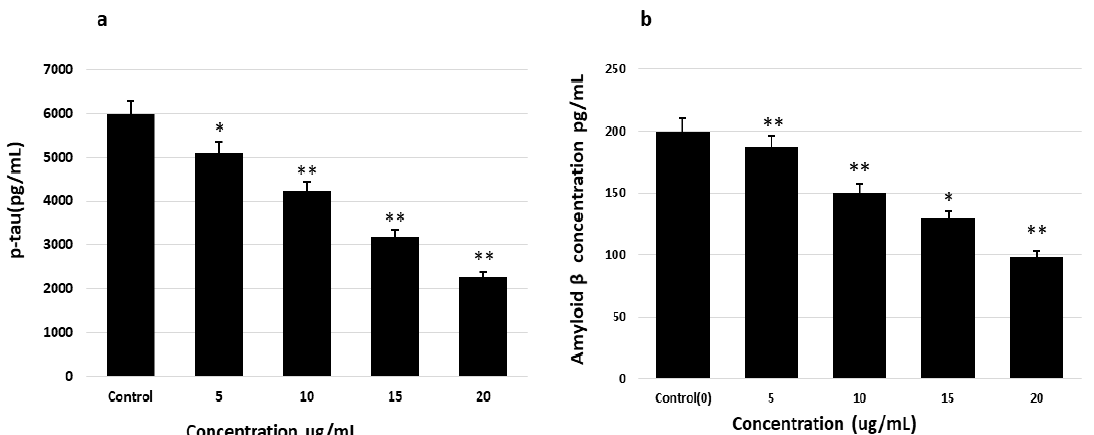
Figure 7. Reduction in the levels of A β peptides and p-tau after treatment with theasaponin (due to enhancement or reduction in the activities of various kinases and phosphatases), determined by ELISA. ( a ) A β quantification with ELISA after the treatment of cells with different concentrations of theasaponin E1. ( b ) p-tau quantification with ELISA after the treatment of cells with different con- centrations of theasaponin E1. Data were analyzed using one-way ANOVA ( n = 3) and expressed as mean ± SEM. Data are statistically significant at p < 0.05 (* p < 0.05; ** p < 0.01 to the control group).